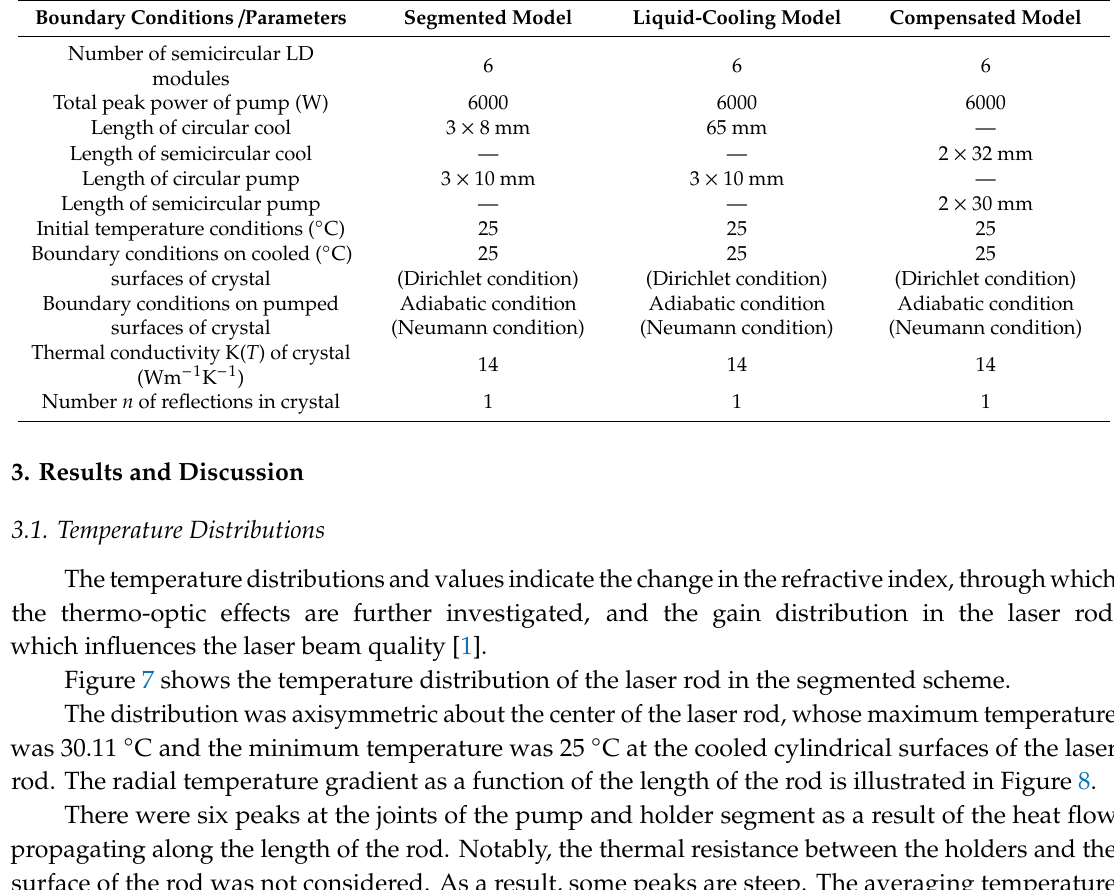
Table 3. The boundary conditions and parameters in the thermal